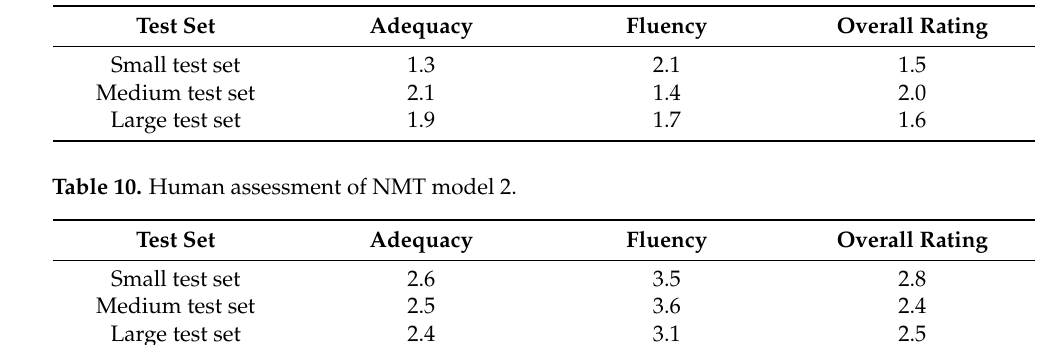
Table 9. Human assessment of NMT model 1.